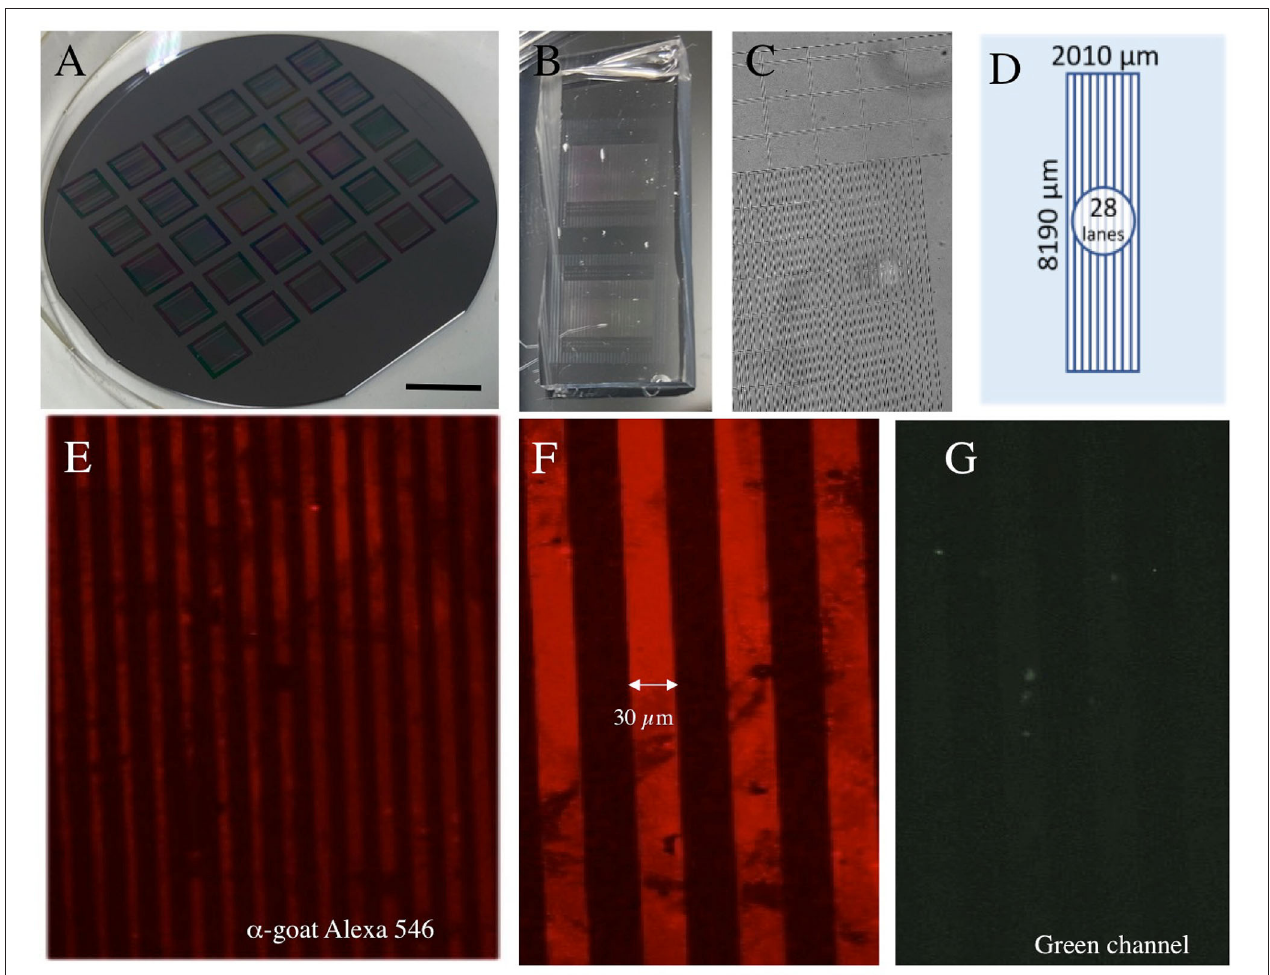
FIGURE 1 | Characterization of microcontact printing ( µ CP). (A) The “silicon wafer master mold” with 6 × 5 stamp masters. (B) Two polydimethylsiloxanes (PDMS) stamps. In (C) the PDMS stamp is seen under a phase-contrast microscope. A typical stamp has a length of 8mm and a width of 2mm including 28 lanes (D) . The microcontact printing was set up with the printing of an anti-goat Alexa-546 antibody showing red lines (E) with 30 µ m size and space (F) , which is not seen in the green channel (G) . Scale bar in A = 1.75cm (A) , 0.5cm (B) , 250 µ m (C) , 140 µ m (E) , 52 µ m (F,G)